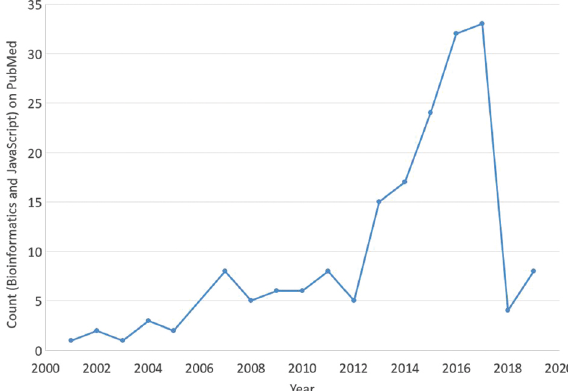
Figure 1: Distribution of the terms bioinformatics and JavaScript on PubMed over the last two